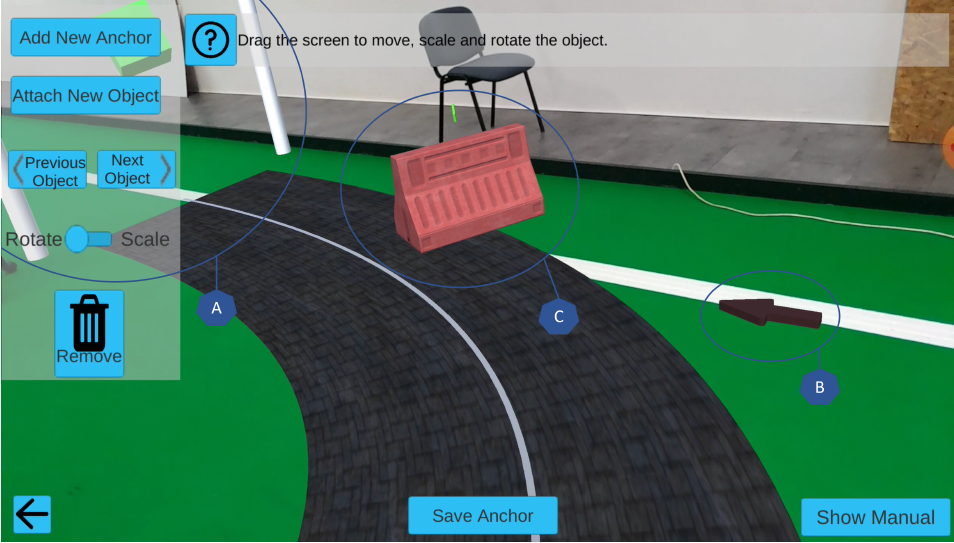
Figure 4. Configuration mode on a smartphone, illustrating how virtual objects can be positioned in the real-world environment. Overview: A—passage points; B—directional arrow; C—obstacle.